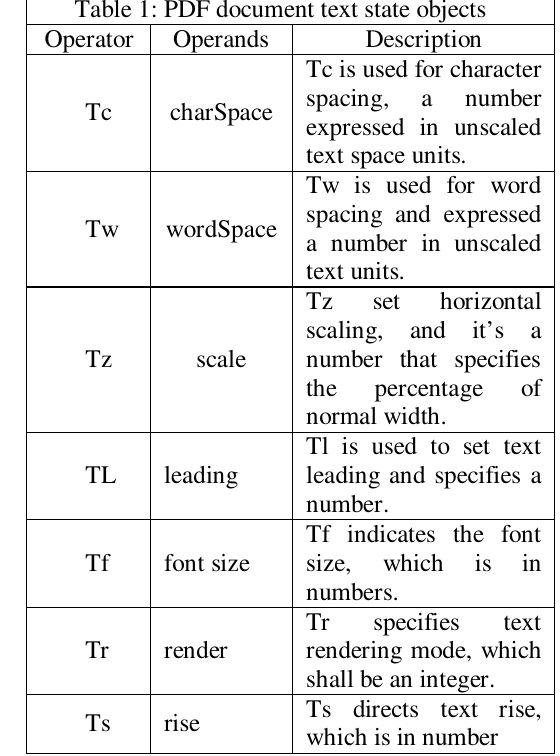
Table 1: PDF document text state